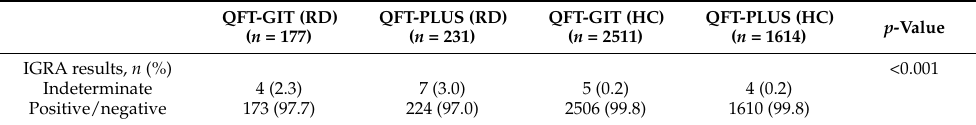
QFT-GIT (RD) QFT-PLUS (RD) QFT-GIT (HC) QFT-PLUS (HC) p -Value ( n = 177) ( n = 231) ( n = 2511) ( n = 1614)